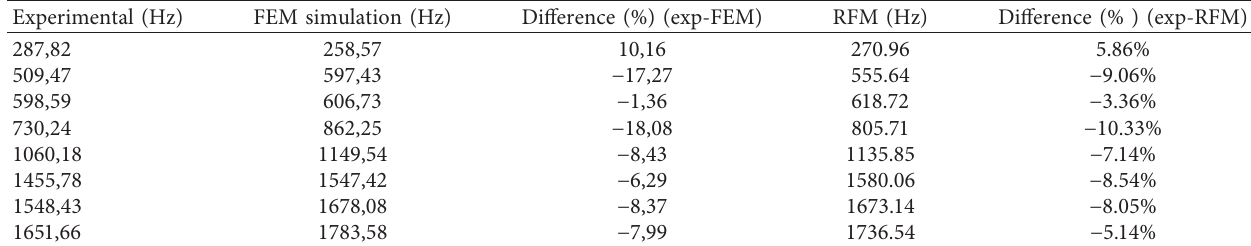
Table 20: Comparison of experimental, FEM, and RFM frequencies (Case